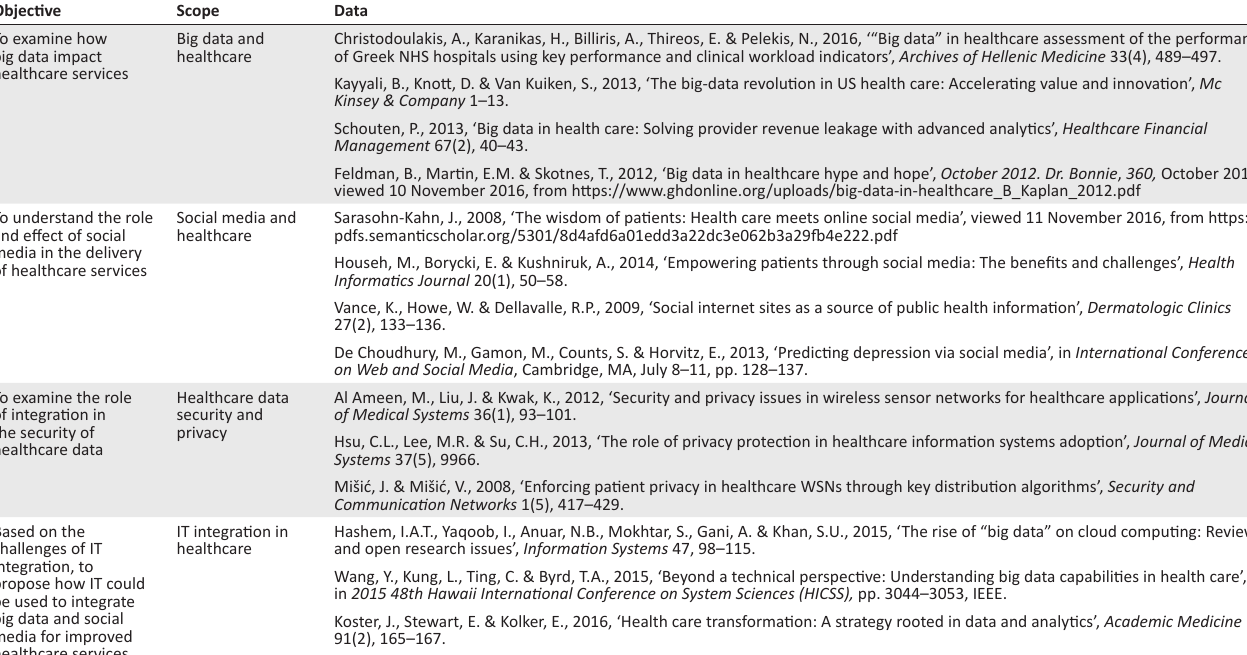
TABLE 1: Existing literature as